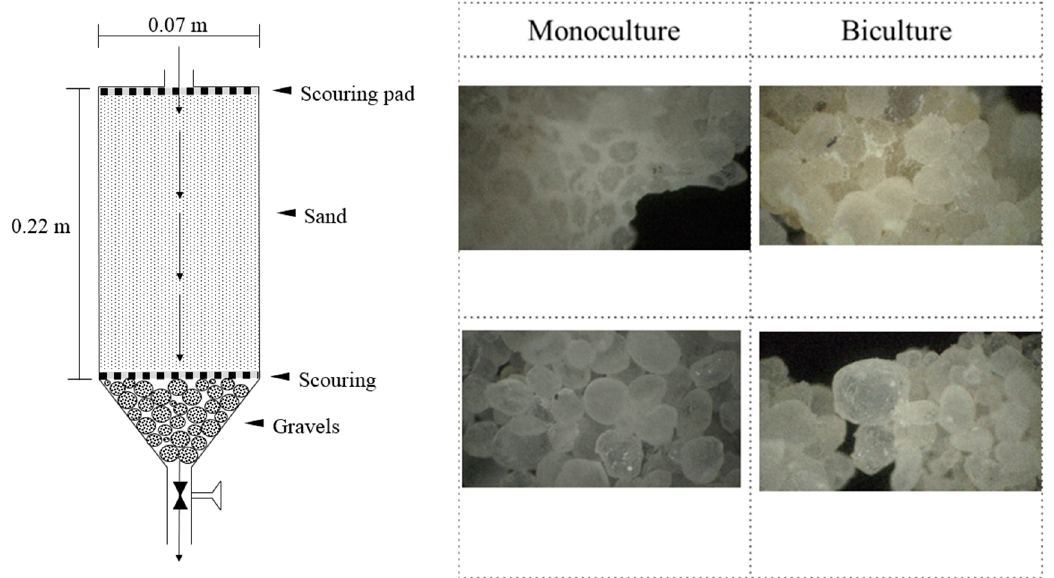
Figure 8. The schematic illustration of the setup and Sampling positions along the columns were indicated at which the samples were analysed by SEM and XRD. The imagines of optical microscopy showed the cemented sands with CaCO 3 precipitates for the scraped samples (Magnification = 0.28 × 20 =